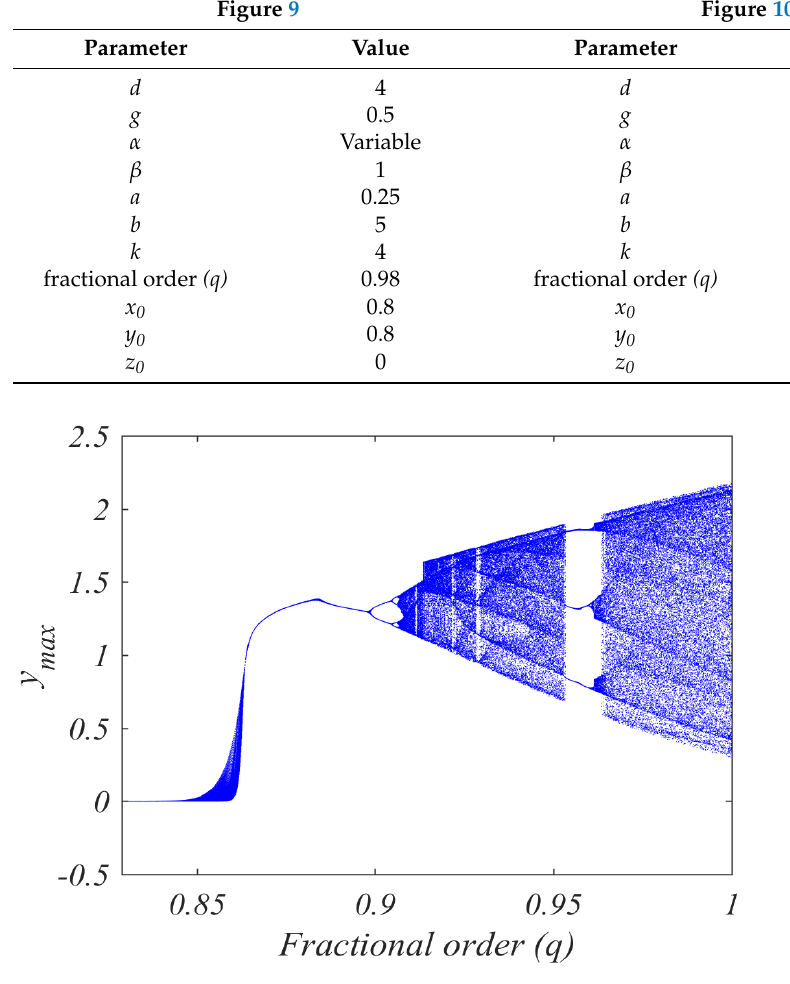
Figure 10. The system (14) bifurcation diagram with respect to changing system fractional order ( q ).